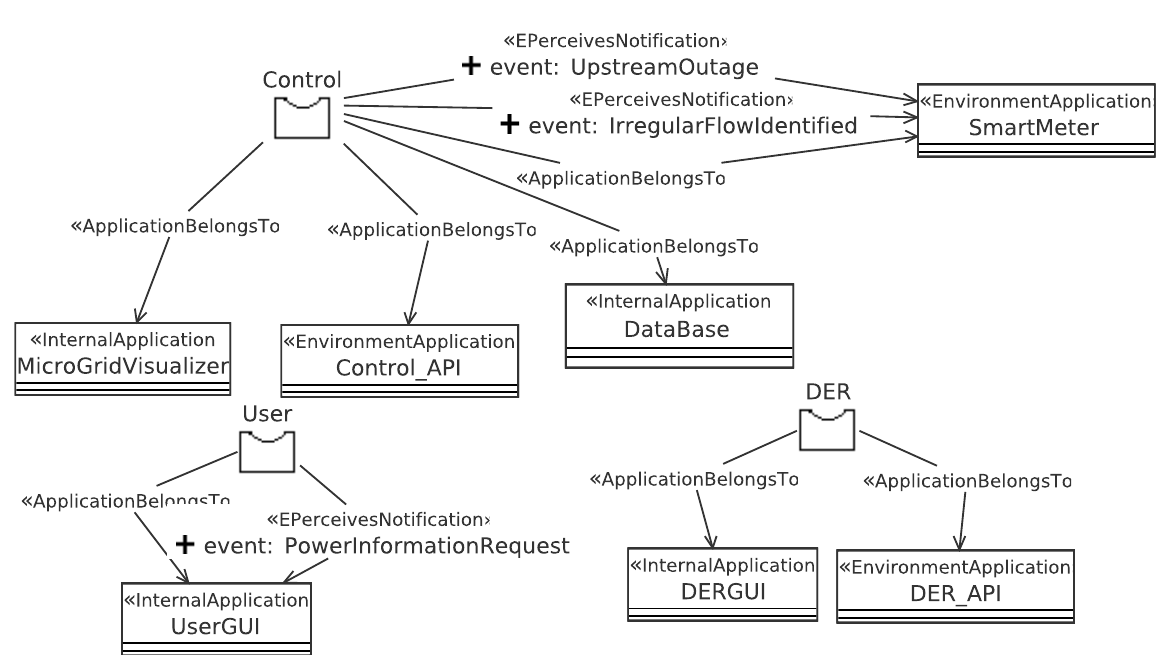
Figure 3. Resources associated to system roles. (API: “Application Programming Interface”; and GUI: “Graphical User